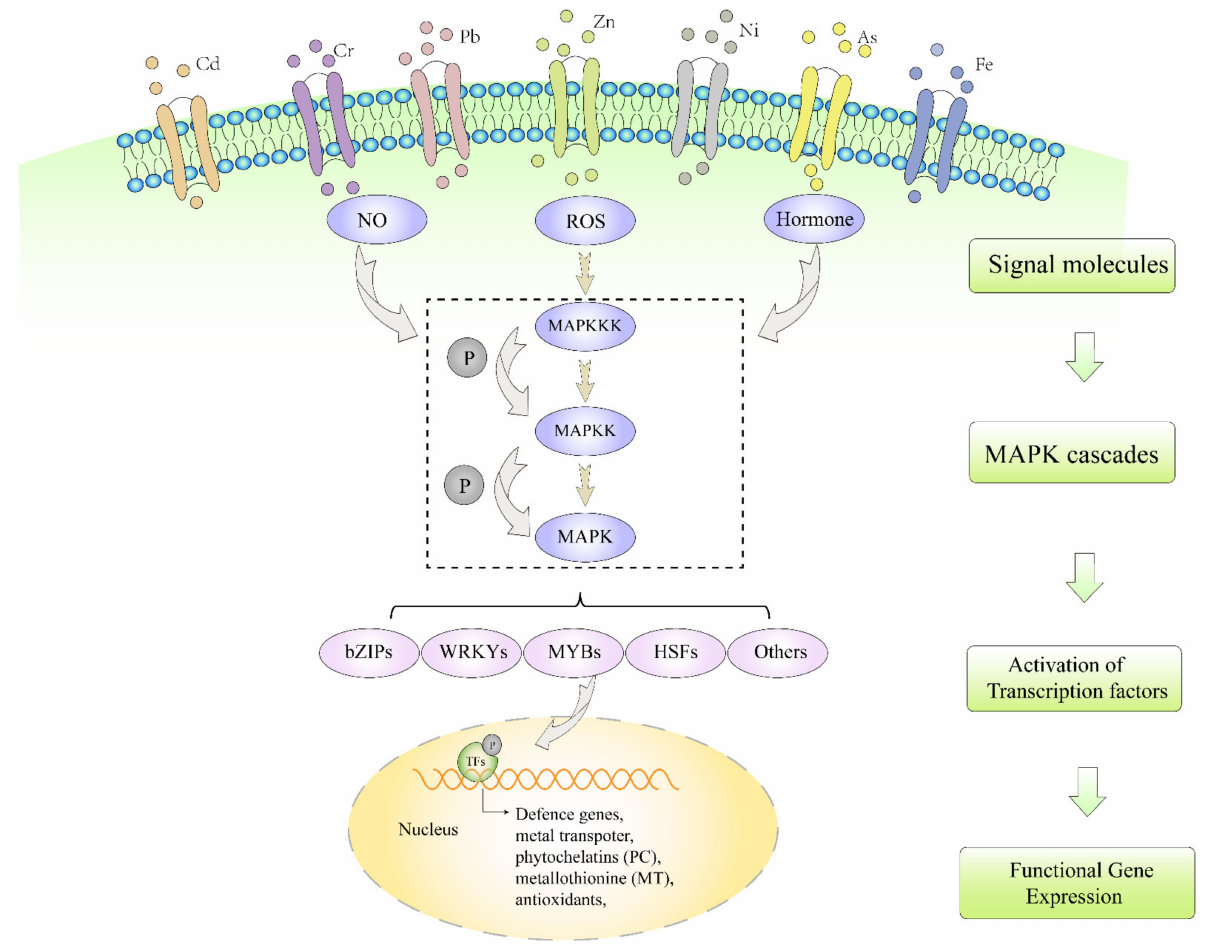
Figure 1. MAPK cascade and transcriptional factors in response to heavy metal stresses in plants. Heavy metal exposure triggers multiple signaling pathways such as NO, ROS and